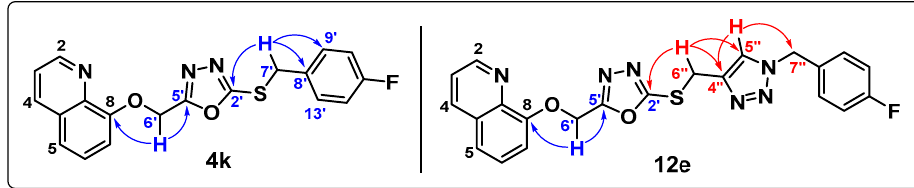
Figure 2. Schematic representation of key HMBC correlations in compounds 4k and 12e.